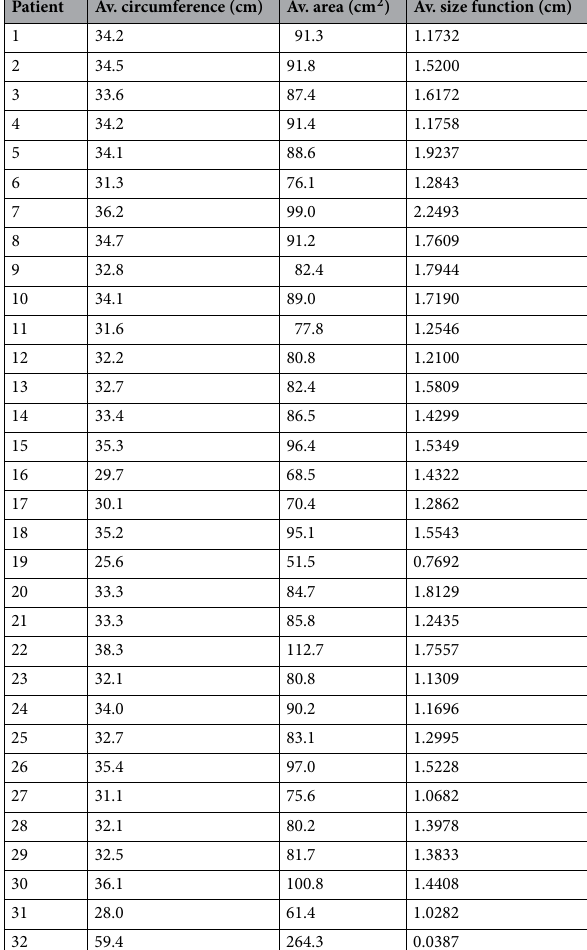
Table 2. Average of the measurements calculated in supine